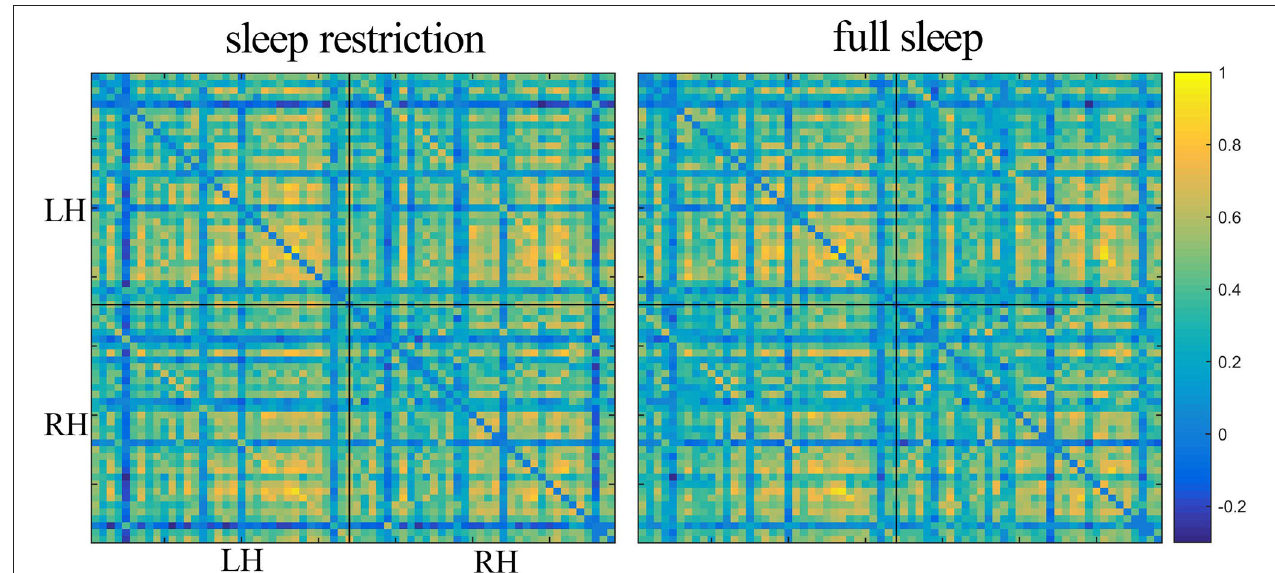
FIGURE 2 | Structural covariance connectivity matrix in the sleep restriction condition (left) and full sleep condition (right) . The color bar denotes Pearson correlation values with warm colors indicating positive correlation, and blue colors indicating negative correlation. Both conditions had similar covariance connectivity pattern. LH, left hemisphere; RH, right